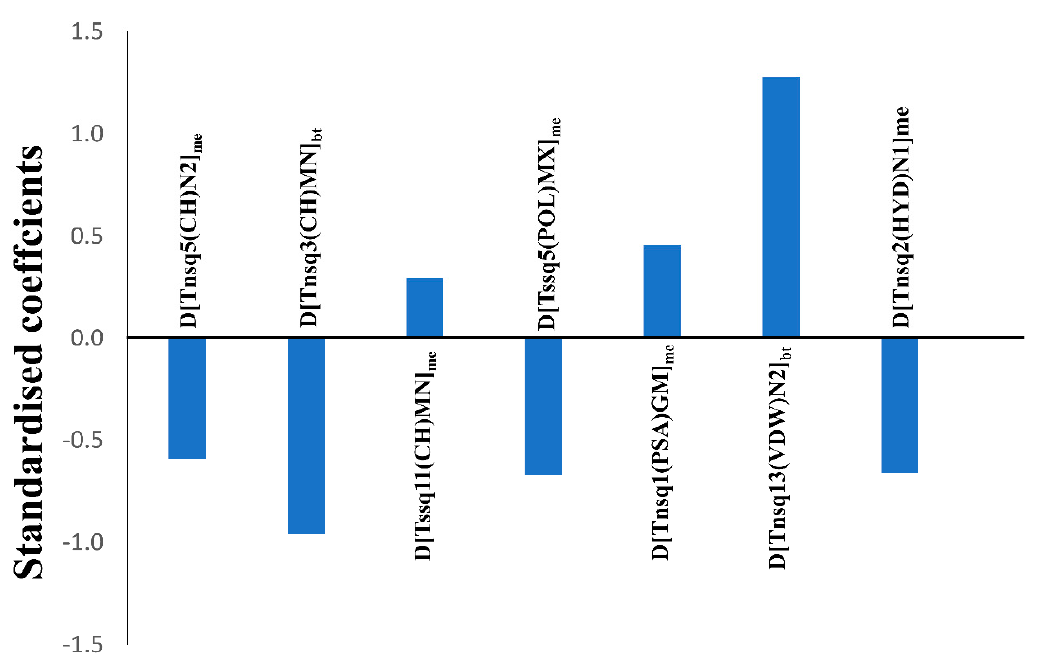
Figure 3. Standardised coefficients vs. variables in the mt-QSAR-LDA model.